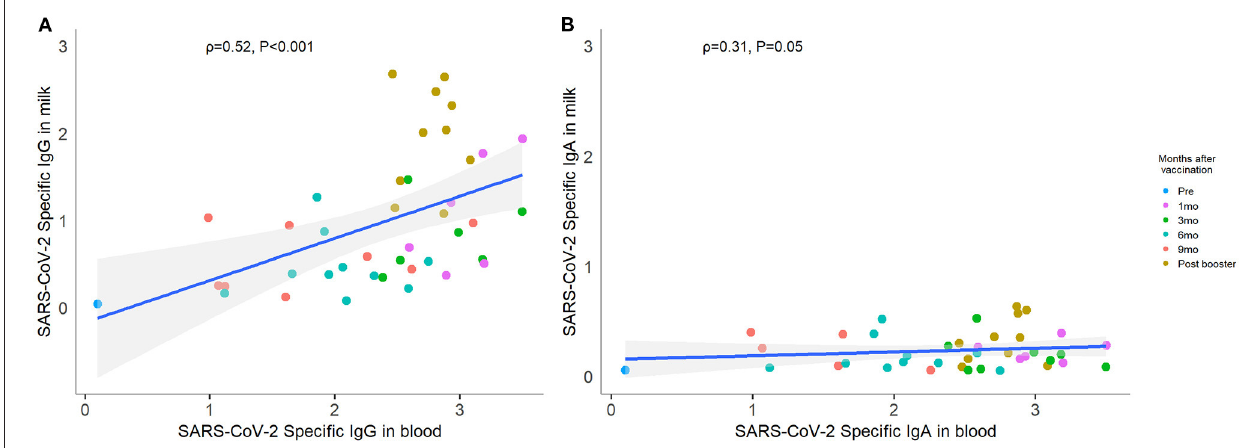
FIGURE 2 | Correlation between paired human milk and blood SARS-CoV-2-specific antibody. Forty-one paired human milk and blood samples collected at the same time point were included in the correlation analysis. Each color point represents each visit. The level of SARS-CoV-2-specific IgG (A) and IgA (B) in breastmilk showed positive correlations with the same isotypes in blood. Correlations were computed using Spearman correlation coefficient labeled ρ .